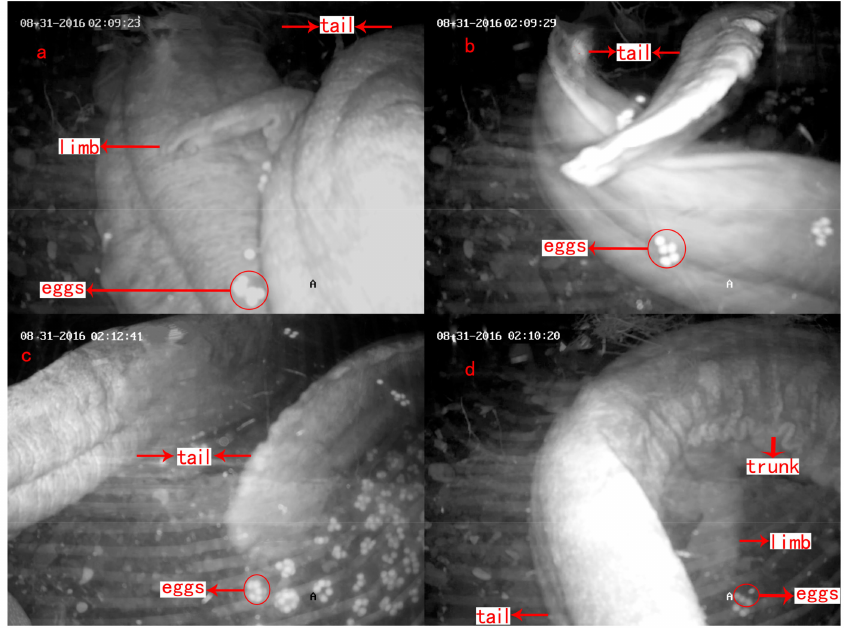
Figure 5. Process of oviposition in A. davidianus : ( a ) the female begins discharging eggs; ( b ) the male and the female’s tails cross; ( c ) the male moves to the entrance of the den; and ( d ) the female body bends into a